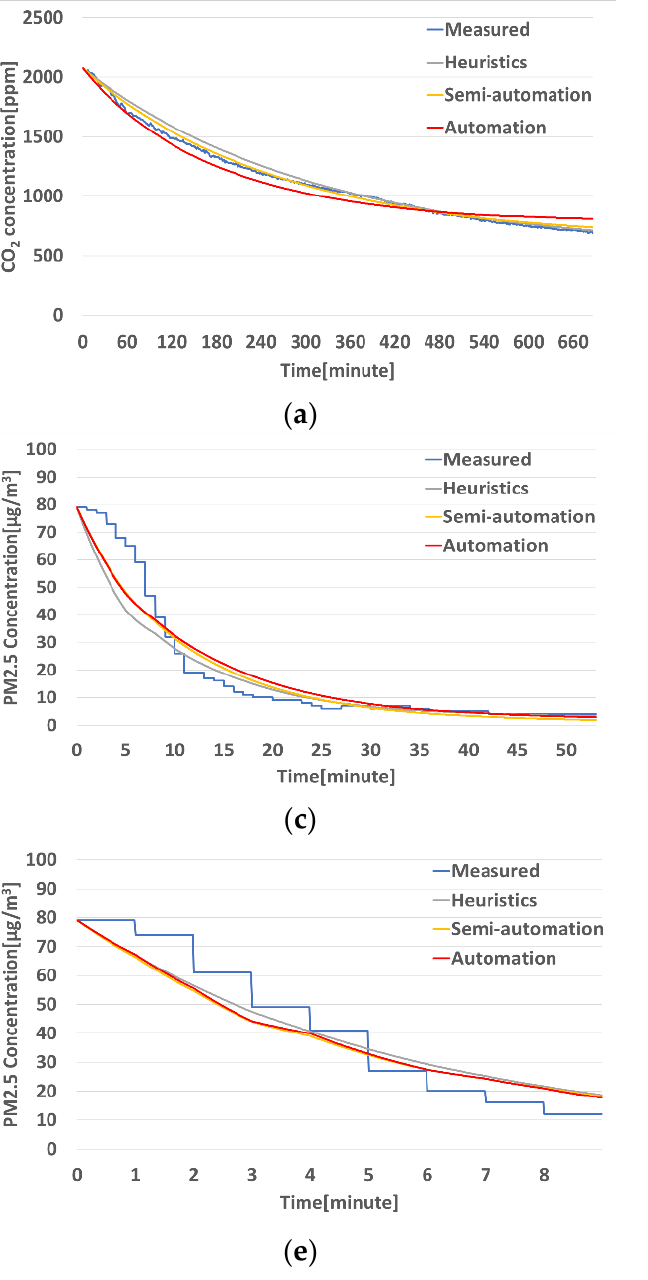
Figure 8. Measured reference and the first principle model responses by the automated, semi-automated, and heuristic calibrations for Case D. ( a ) CO 2 decay scenario. ( b ) PM2.5 decay scenario. ( c ) Door-open scenario. ( d ) Window-open scenario. ( e ) Cross-ventilation scenario. ( f ) Air purifier scenario.